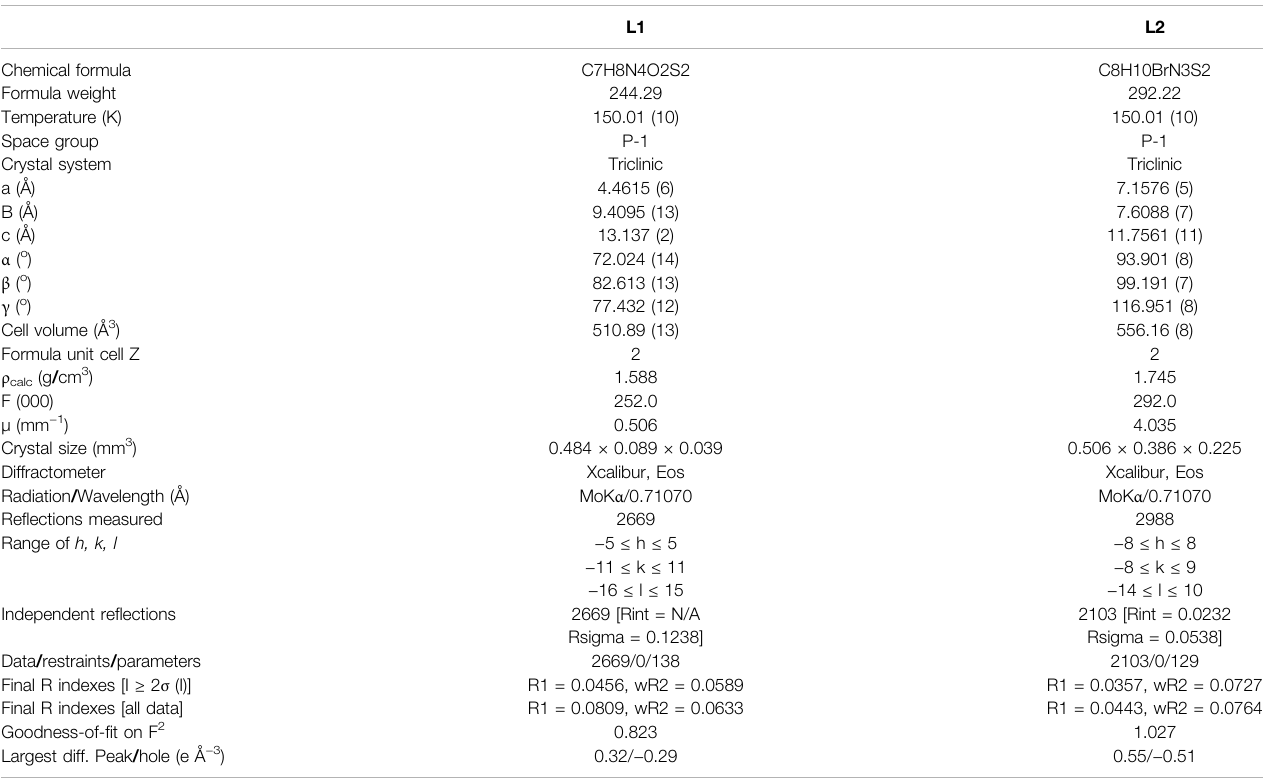
TABLE 1 | Crystal data and structure re fi nement parameters for complexes L1 and L2.